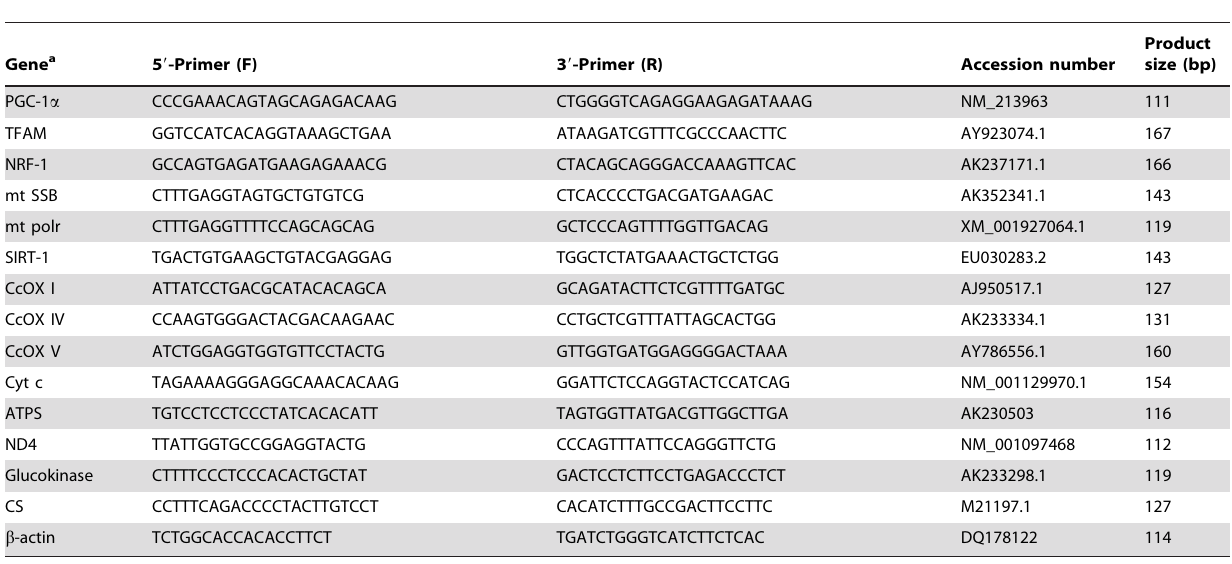
Table 3. Primer sequences of target genes used for real-time RT-PCR.